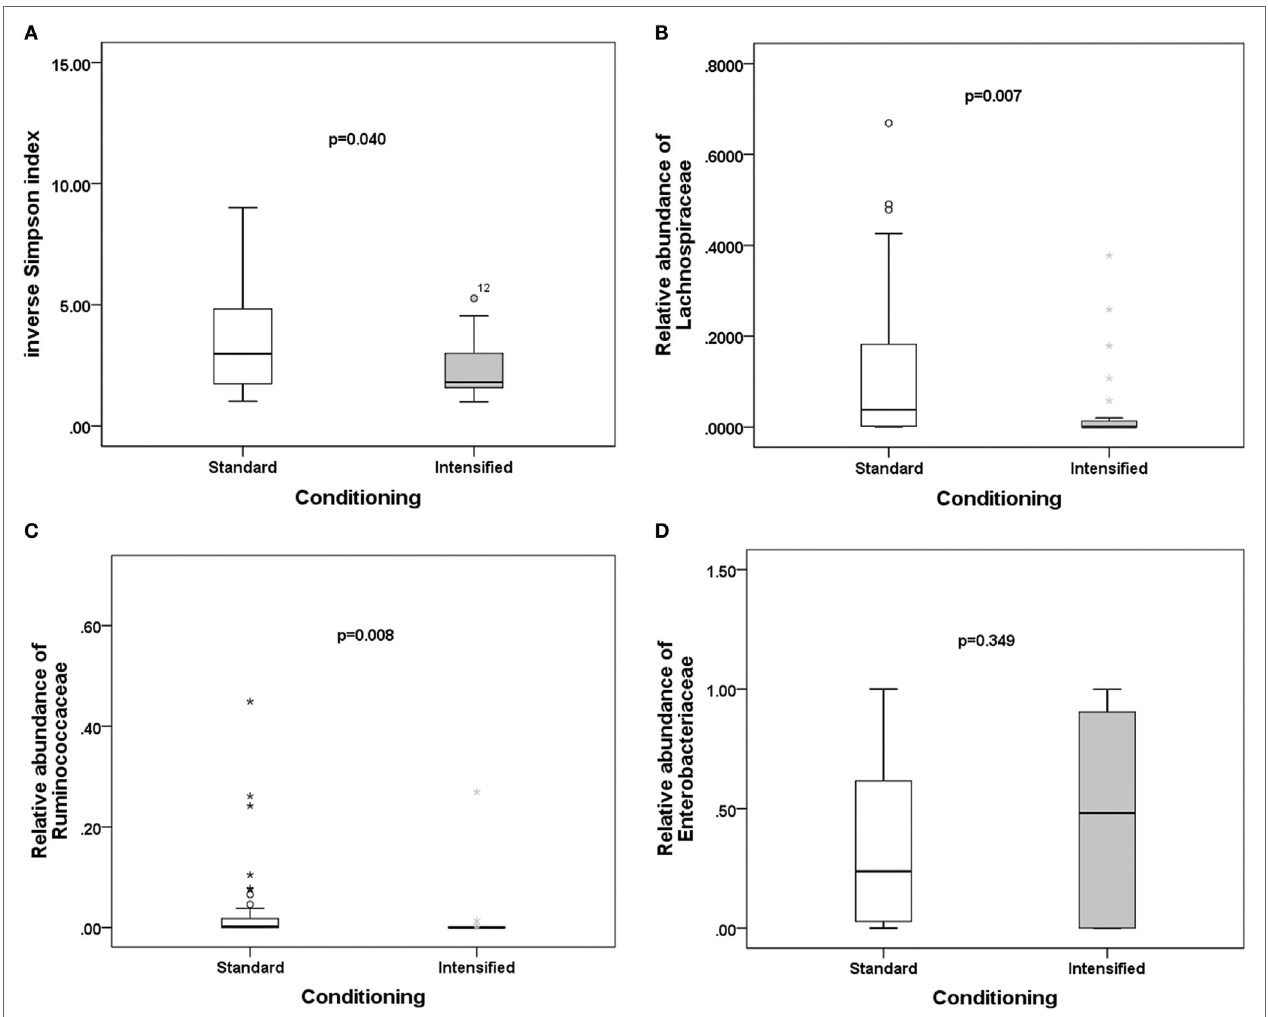
FigUre 5 | Differences in the intestinal microbiota (diversity and composition) are associated with conditioning intensity in allo-HSCT patients. (a) Differences in microbiota diversity, (B) relative abundance of the Lachnospiraceae, (c) Ruminococcaceae, and (D) Enterobacteriaceae families between standard and intensified